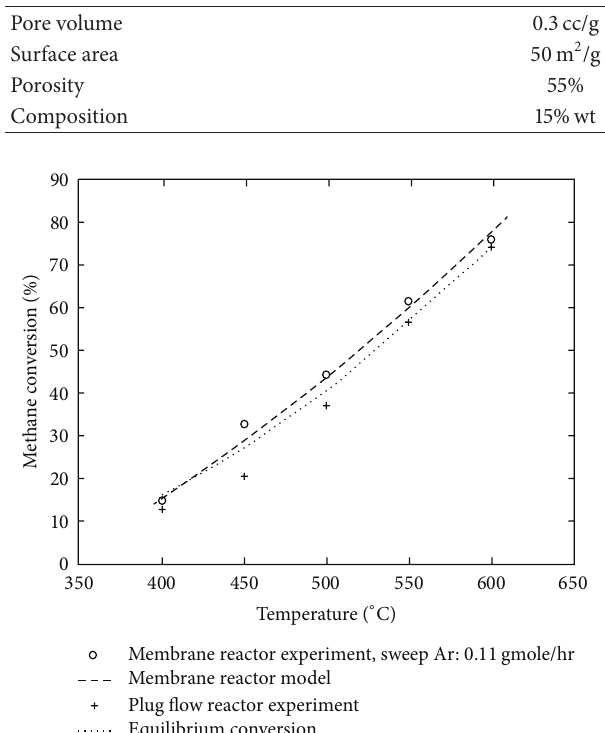
Table 3: Catalyst characteristics.